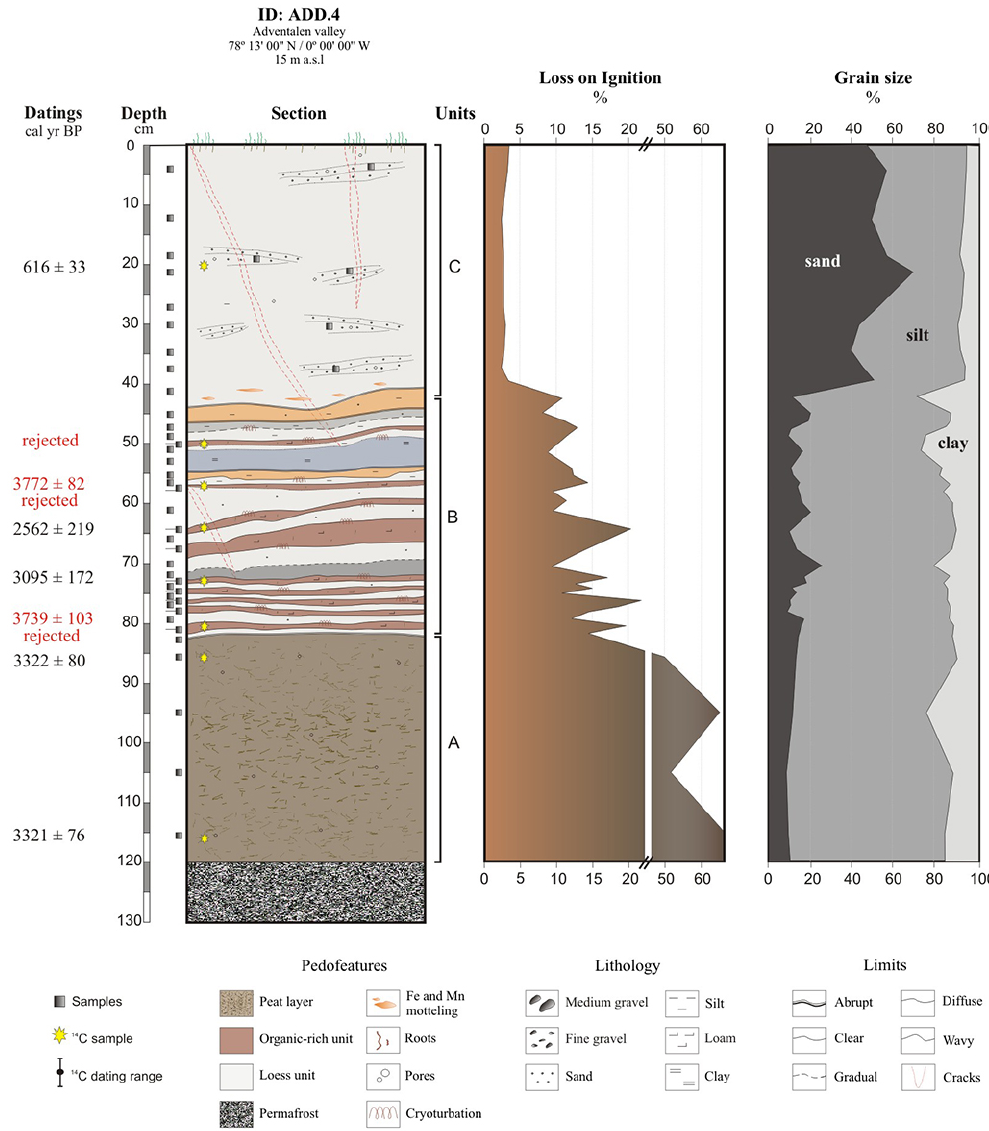
Figure 4. Lithostratigraphic section ADV.20 together with 14 C datings, LOI and grain size properties. Table 2. Descriptive statistics of the studied elements (% of LOI, sand, silt and clay) in sections ADD.4 and ADV.20. Significant differences are indicated by *( p <0.05) and ** ( p <0.001); n.s. stands for “not significant” at a p